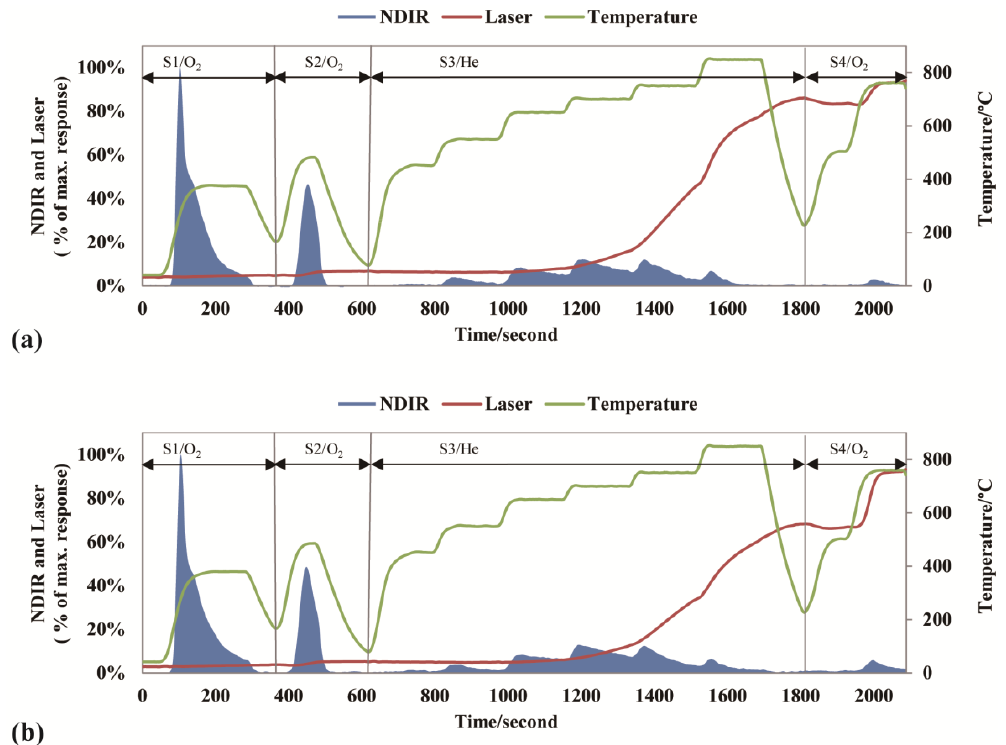
Fig. 6. Fig. 6. Thermograms from the analysis of two water-extracted winter samples CHI (a) , and MOL (b) . The protocol used for analysis was modified according to the Swiss 4S protocol (see in Table 2) with a fixed peak S2 temperature of 475 ◦ C, but with different steps in S3 (He mode): 450 ◦ C, 550 ◦ C, 650 ◦ C, 700 ◦ C, 750 ◦ C and 850 ◦ C, each of 180s.